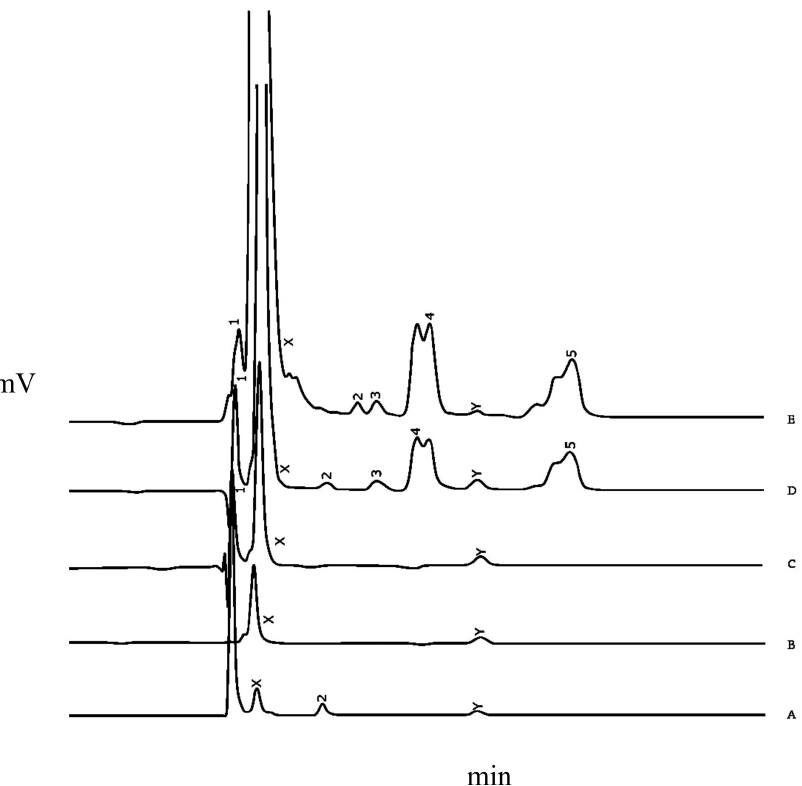
= 3.425) and dexamethasone (t = 7.794) under acidic, basic, thermal, FIGURE - 3 A typical chromatogram of sparfloxacin (t R R photolytic and oxidative stress conditions. Where (X) is sparfloxacin peak, (Y) dexamethasone peak, (1, 2, 3, 4, and 5) degradation/ impurities peaks, (A) chromatogram of oxidative stress, (B) chromatogram of thermal stress, (C) chromatogram of acidic stress, (D) chromatogram of basic stress and (E) chromatogram of photolytic stress. Chromatographic conditions: mobile phase methanol: 0.02 M phosphate buffer (60:40, v/v), pH 3.0, Column BDS Hypersil C8 (250 X 4.6, 5 µm), flow rate 1.5 mL min -1 , injection volume 20 µL, wavelength 270